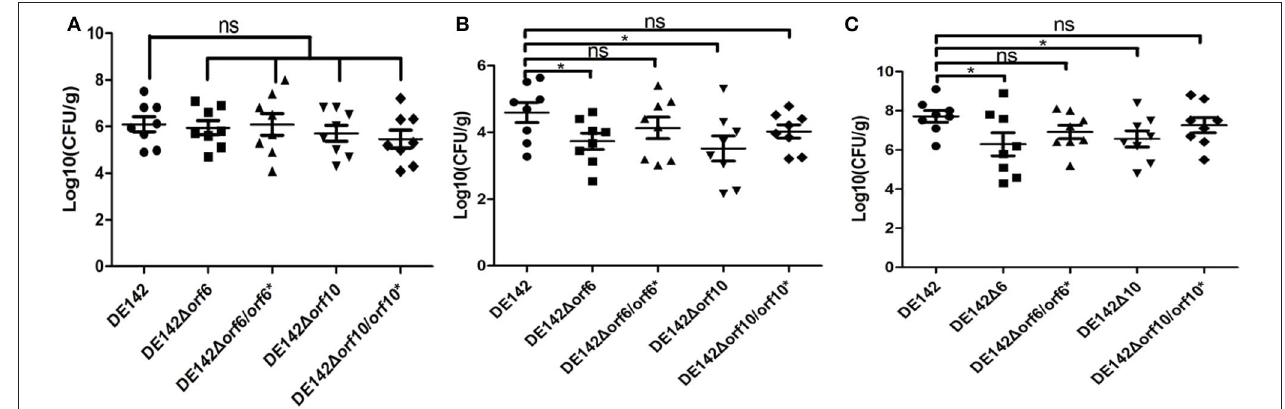
FIGURE 5 | Bacterial colonization during infection in vivo. Infection of chickens via the air sacs with 2 × 10 7 CFU of WT DE142, DE142 1 orf6 , DE142 1 orf6 / orf6 *, DE142 1 orf10 , or DE142 1 orf10 / orf10 *. After 24h post-infection, bacterial re-isolation from the (A) lung, (B) heart, and (C) blood was quantified by the plate counting method. Each data point represented a sample from an individual chicken. The Mann-Whitney U -test was performed for significance, * P < 0.05.